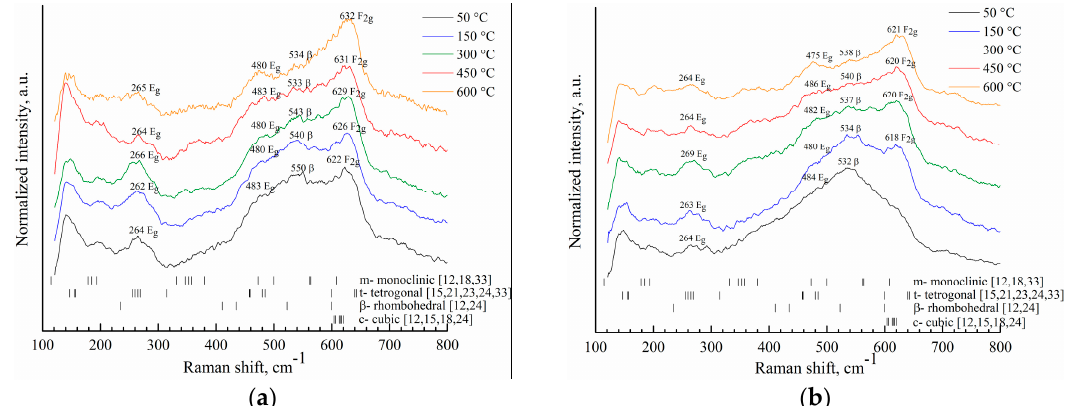
Figure 4. Raman spectra of ( a ) ScSZ and ( b ) ScSZAl thin films deposited on Alloy 600 substrates using a 0.4 nm/s deposition rate.